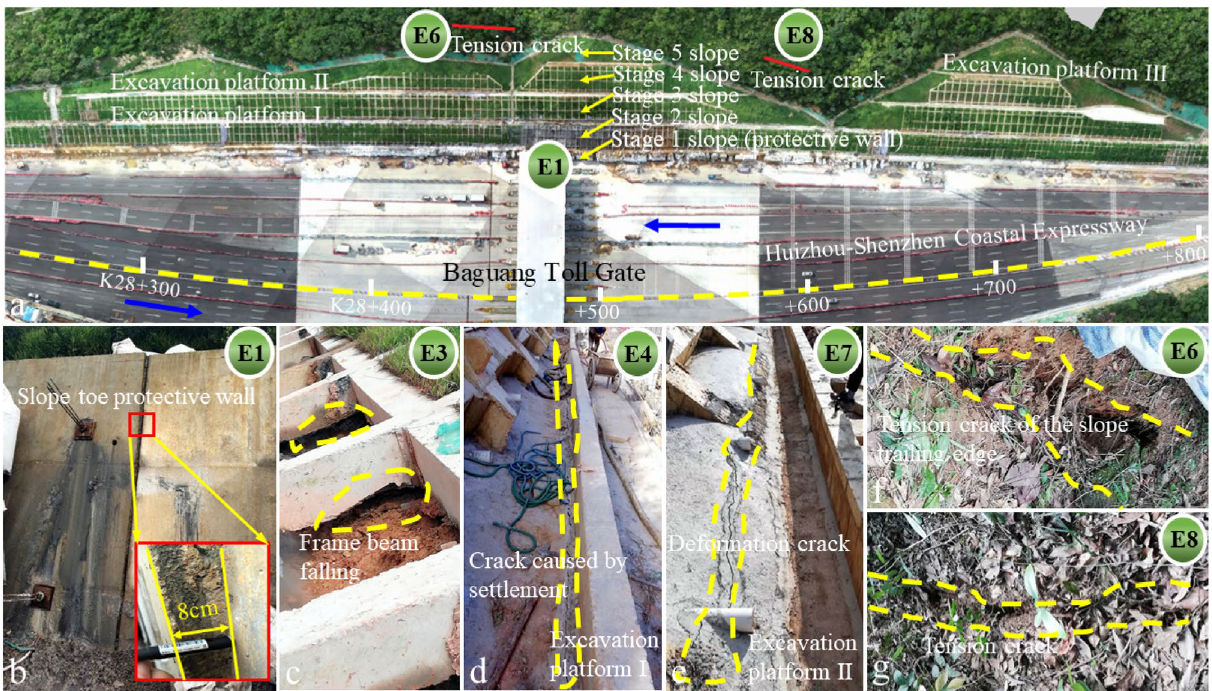
Figure 11. The panoramic photo of the supported slope, and the damage phenomenon in the deformation and failure evolution process (E1-E8 correspond to the time nodes in Fig. 9). ( a ) Supporting structure of slope; ( b ) deformation characteristics of the slope toe protective wall; ( c ) the first order frame beam deformed, damaged and out of ground contact; ( d,e ) drainage facilities cracking caused by the slope deformation; ( f,g ) tension cracks at the slope trailing